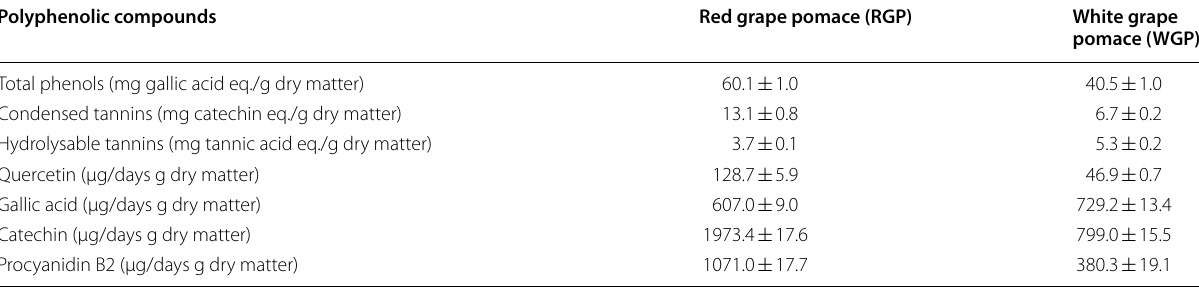
Table 1 Phenolic compounds in red wine and grape pomace. Adapted from Martins et al.